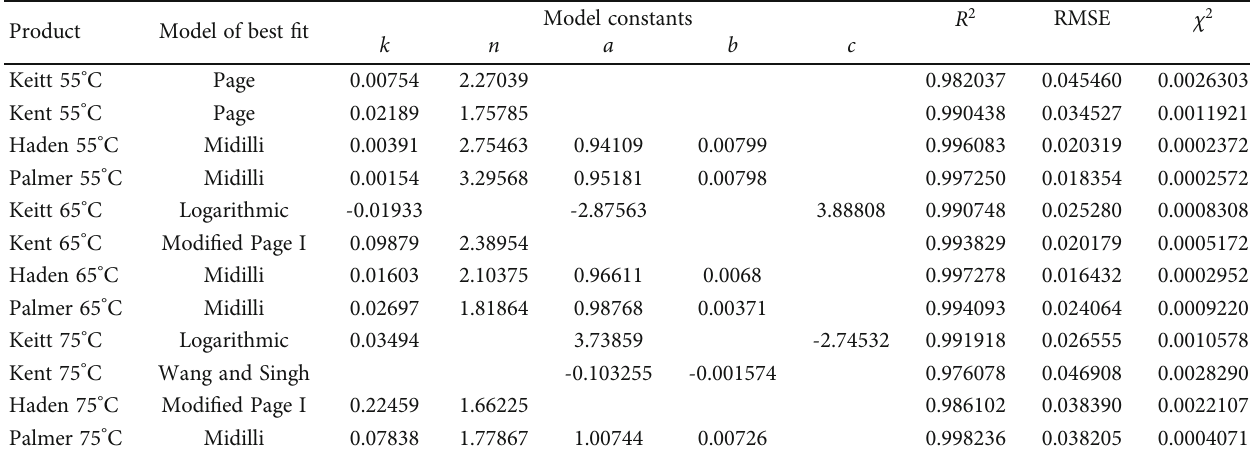
Figure 5: E ff ective moisture di ff usivity of mango. Table 2: Mathematical modelling for thin layer drying of